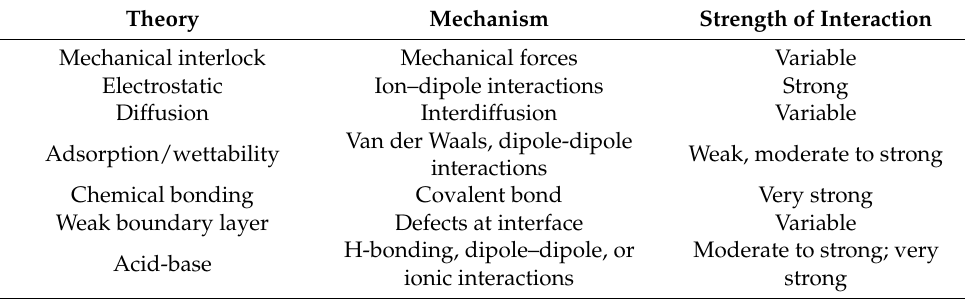
Table 2. Adhesion theories and possible